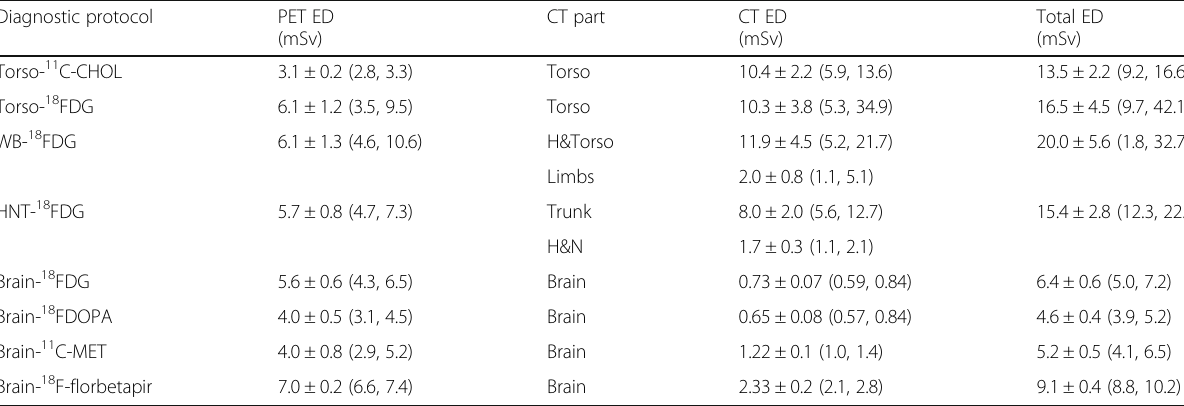
Table 4 Effective dose for PET/CT protocols with PET and CT contributions* Diagnostic